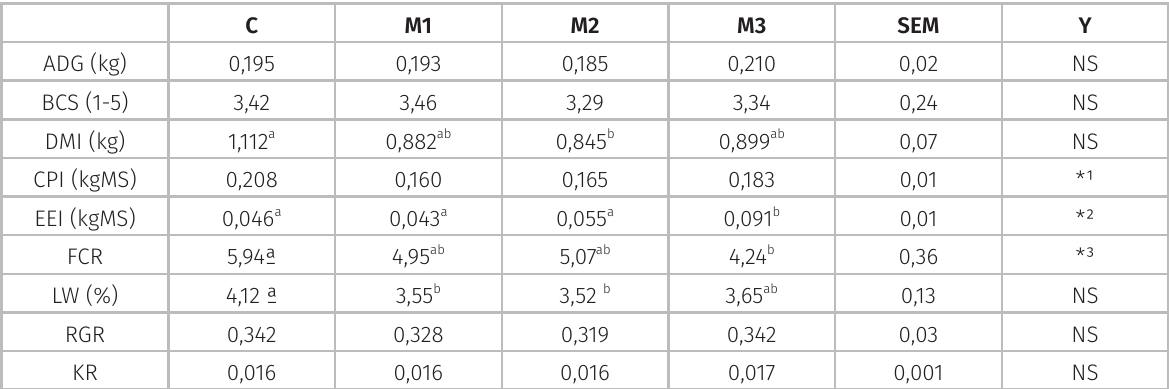
Table III. Performance and feed efficiency of lambs fed levels of macadamia